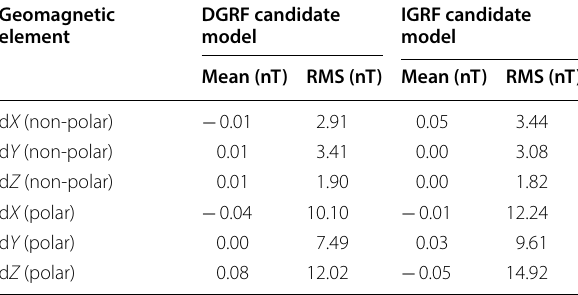
Table 2 Means and RMS errors obtained for the geomagnetic observatory data for both DGRF and IGRF parent models.